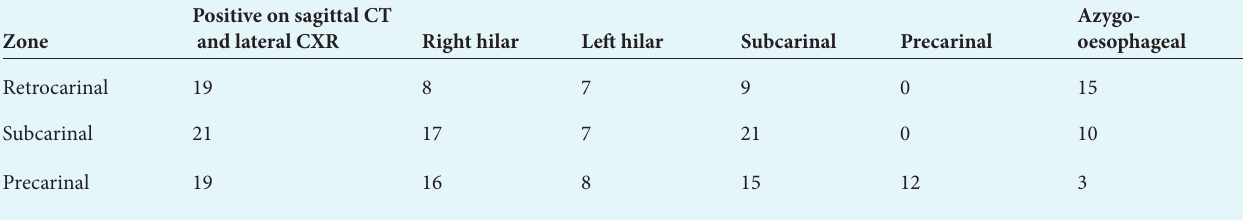
Table 4. Contribution of lymph node groups to defined zones on sagittal CT (and by inference on lateral CXR) using only true positives (see Table 3)